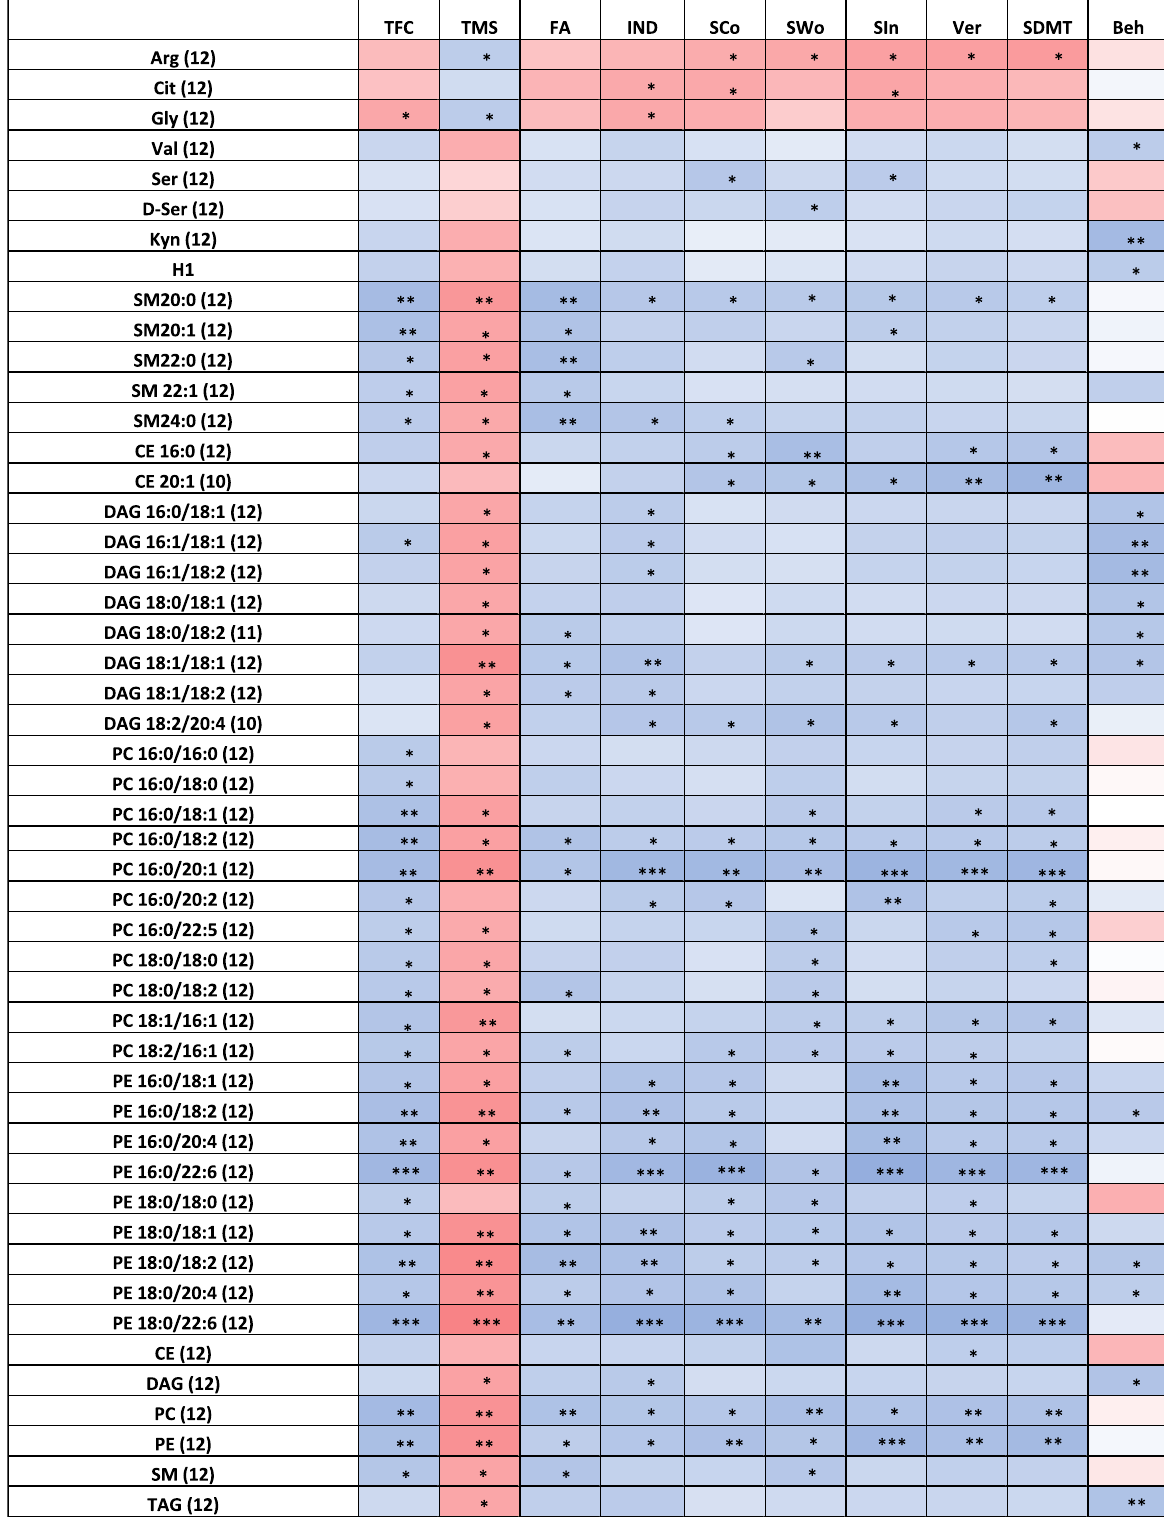
Figure 1. Correlations between metabolites in plasma and clinical outcomes. r-value correlations of − 0.7 to − 1.0 ( ) , − 0.4 to − 0.69 ( ) , 0.7 to 1.0 ( ) and 0.4–0.69 ( ) are shown; nominal p values represented as follows: *0.01 < p < 0.05; **0.001 < p < 0.01 and *** p <